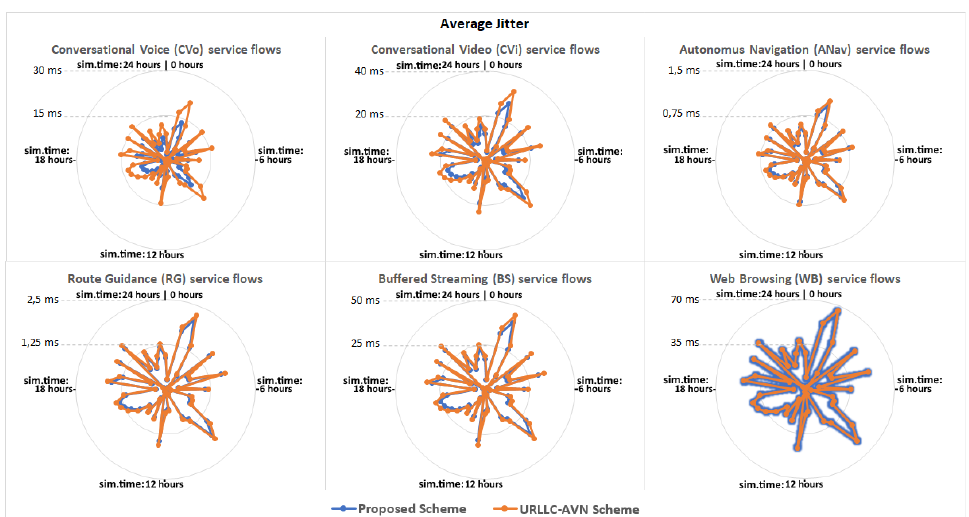
Figure 7. The average jitter observed for each service type.